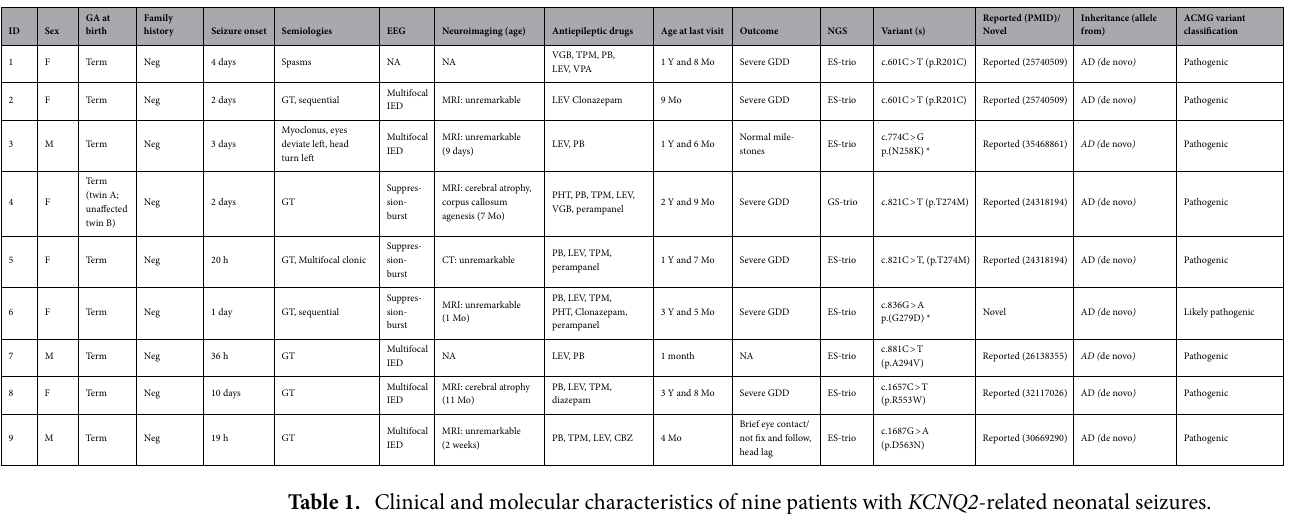
Table 1. Clinical and molecular characteristics of nine patients with KCNQ2 -related neonatal seizures. CBZ, carbamazepine; CT, computerized tomography; EEG, electroencephalogram; F, female; FLAIR, fluid attenuation inversion recovery; GDD, global developmental delay; GT, generalized tonic seizures; GTC, generalized tonic clonic seizures; rs, hours; ID, identification; IED, interictal epileptiform discharges; LEV, Levetiracetam; LGA, large for gestational age M, male; Mo, months; MRI, magnetic resonance imaging; NA, not available; NCSE, nonconvulsive status epilepticus; Neg, negative; NGS, next-generation